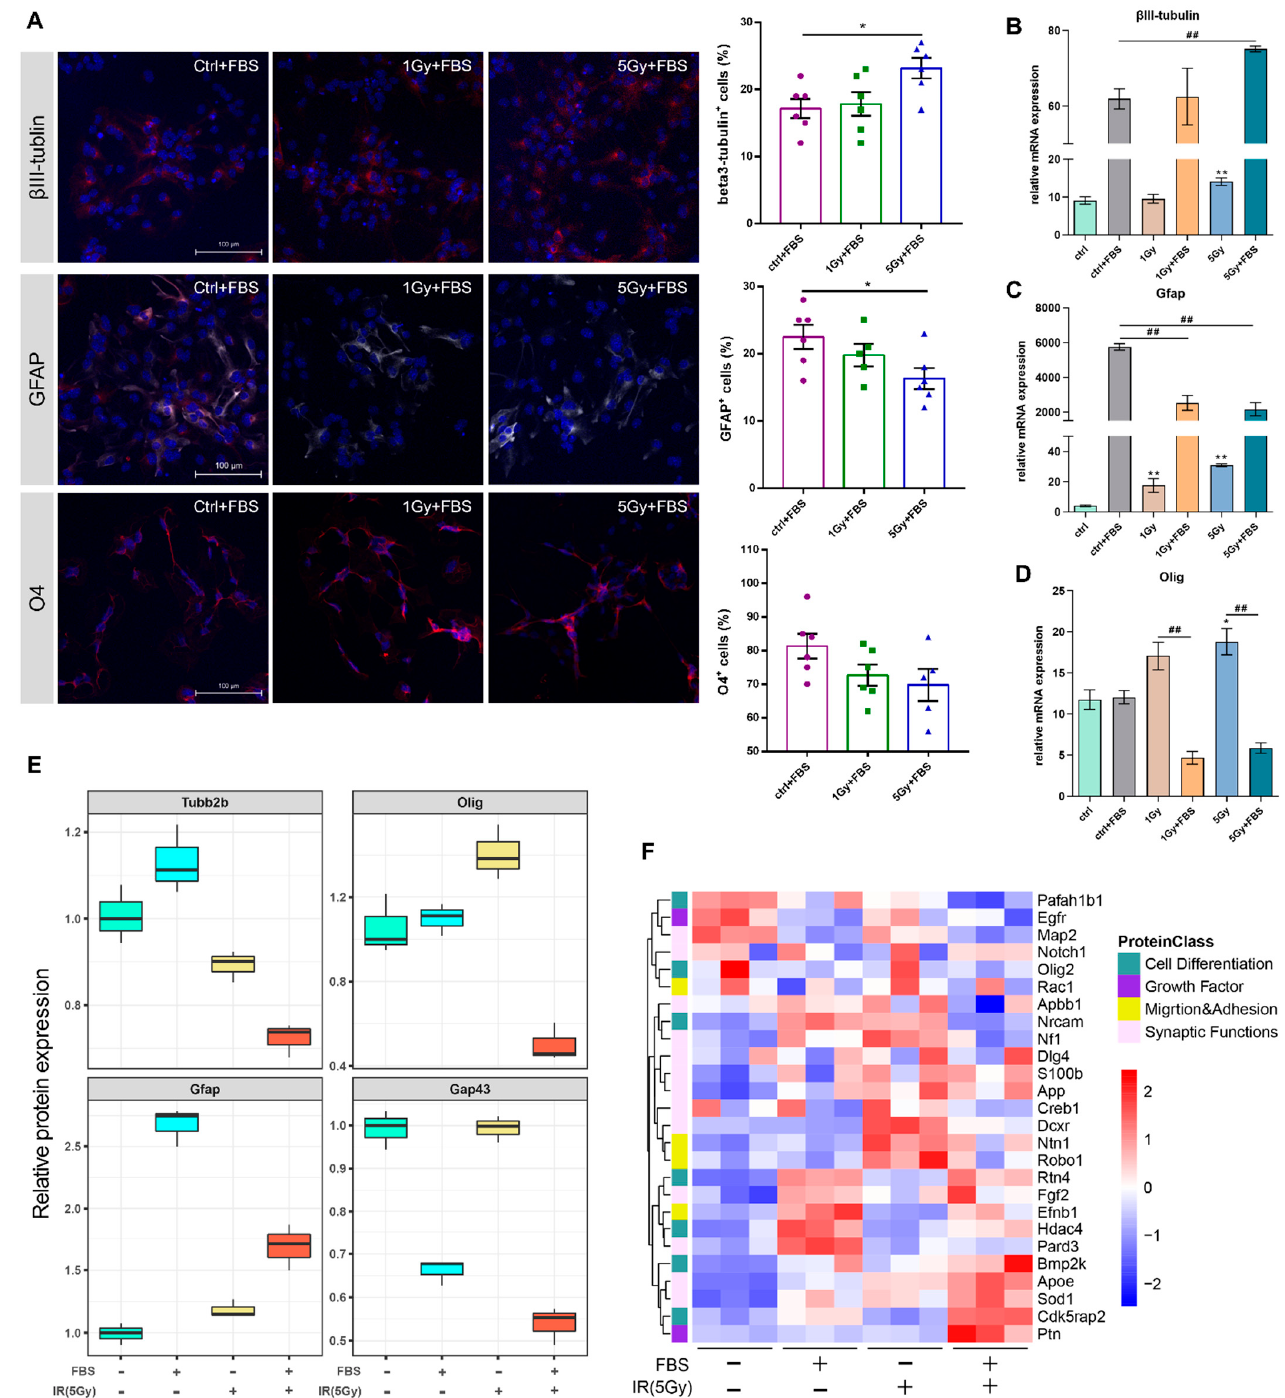
Figure 4. Assessment of differentiation in irradiated NSCs and visualization of neurogenesis-related proteins. ( A ) The confocal images depict representative immunostained cells for each phenotypic marker. Bar graphs depicting the expression percentages; data were represented as Mean ± SEM; n = 3; * p < 0.05 as compared with the indicated group. ( B – D ) Bar graphs representing the relative mRNA expressions of phenotypic marker genes. n = 3; Mean ± SEM. * p < 0.05, ** p < 0.01 as compared with the control group; ## p < 0.01 for comparisons between indicated groups. ( E ) Boxplot graph illustrating the relative expressions of cell-specific proteins selected from the MS/MS dataset. ( F ) Heatmap indicating the relative protein expressions among different treatment groups (red, upregulated; blue, downregulated), differently annotated color blocks represent different classes of the